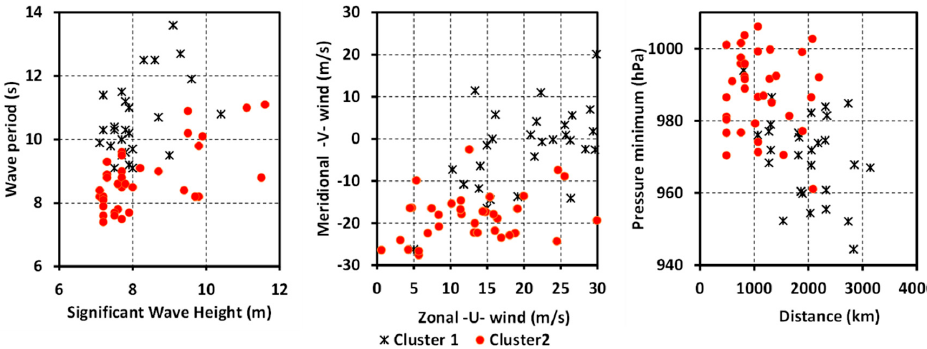
Figure 3. Scatterplots representing atmospheric properties defined by cluster ( left ), significant wave height versus wave period ( center ), zonal wind component versus meridional wind component (right ), and the distance of the forcing cyclone versus